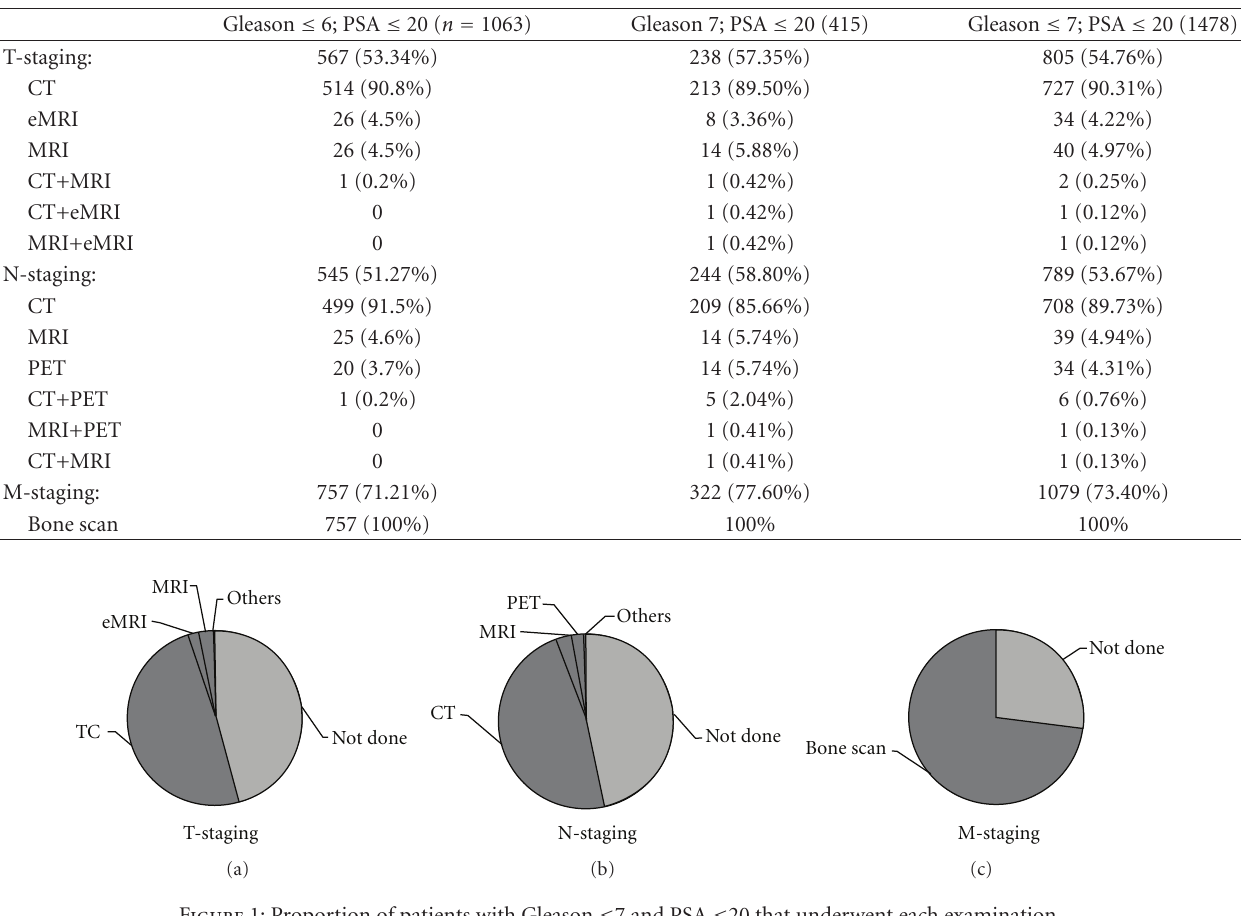
Figure 1: Proportion of patients with Gleason ≤ 7 and PSA ≤ 20 that underwent each